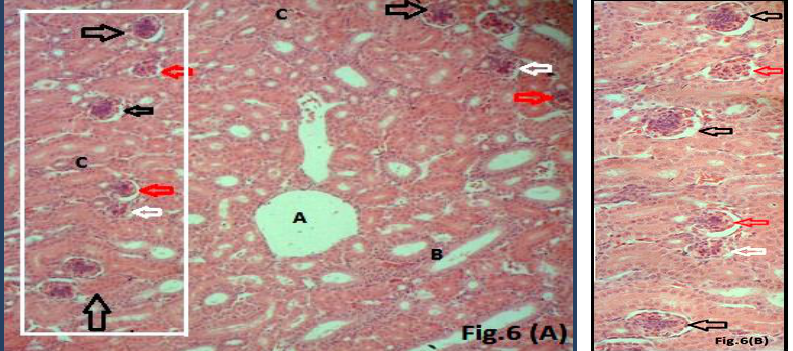
Figure, 8: Histological section of Chicken kidneys: (A) show: (A) Central vein. (B) Medulla. (C) Cortex. (Black arrows show mammalian Glomerulus - Red arrows show intermediate Glomerulus - White arrows show reptilian Glomerulus) H&E stain100x. (B) is magnifying of white box in left figure- 400x.